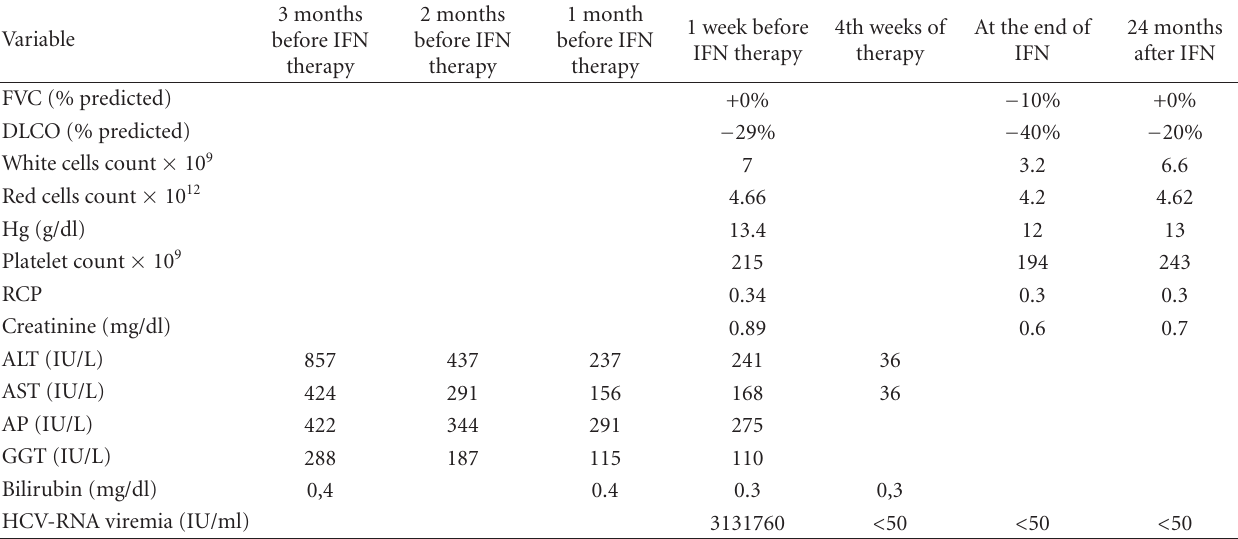
Table 1: Disease activity